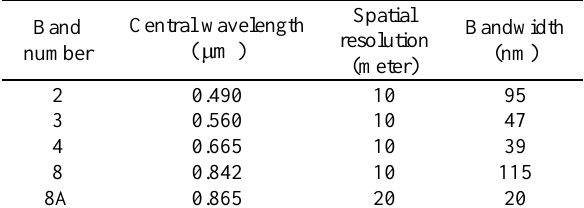
Table 1. Spectral properties of Sentinel-2 band 2, 3, 4, 8 and